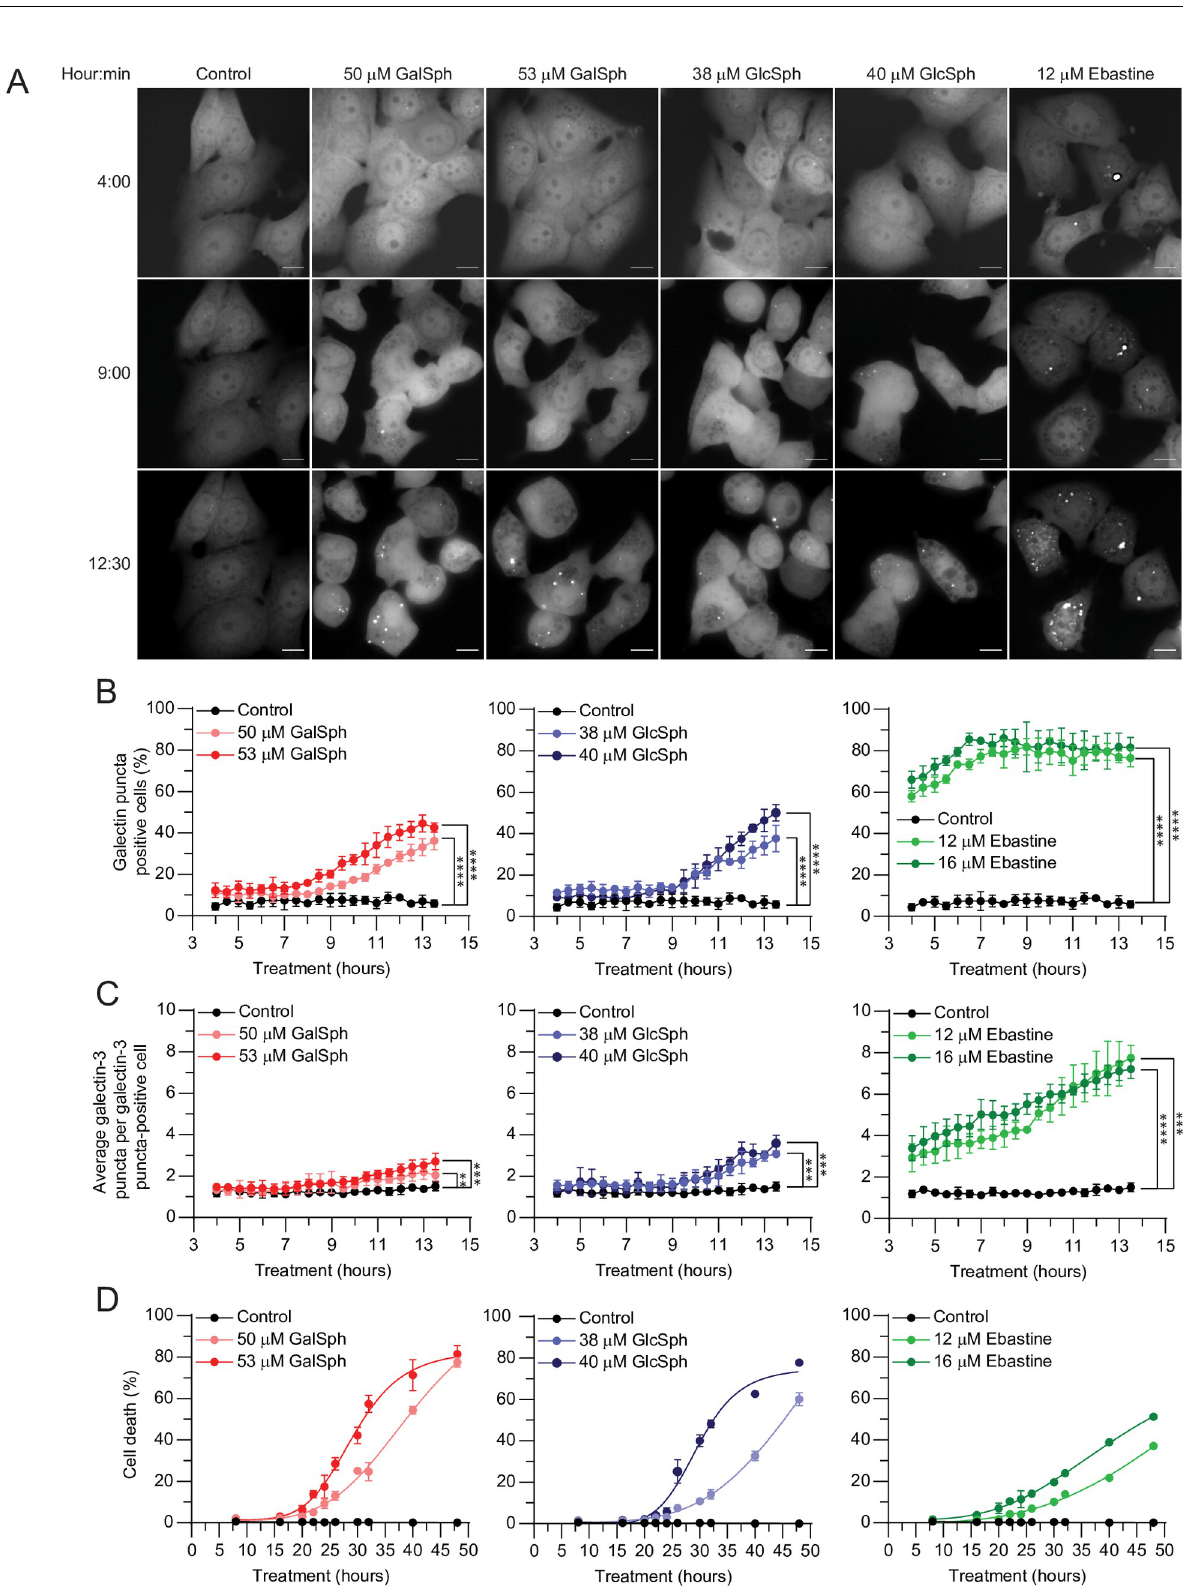
Fig 3. GalSph and GlcSph induce lysosomal membrane permeabilization in MCF7 galectin-3-eGFP cells. (A) Representative images of MCF7 galectin-3-eGFP cells treated with indicated concentration of GalSph, GlcSph, or ebastine for indicated times (hour:min) were acquired using